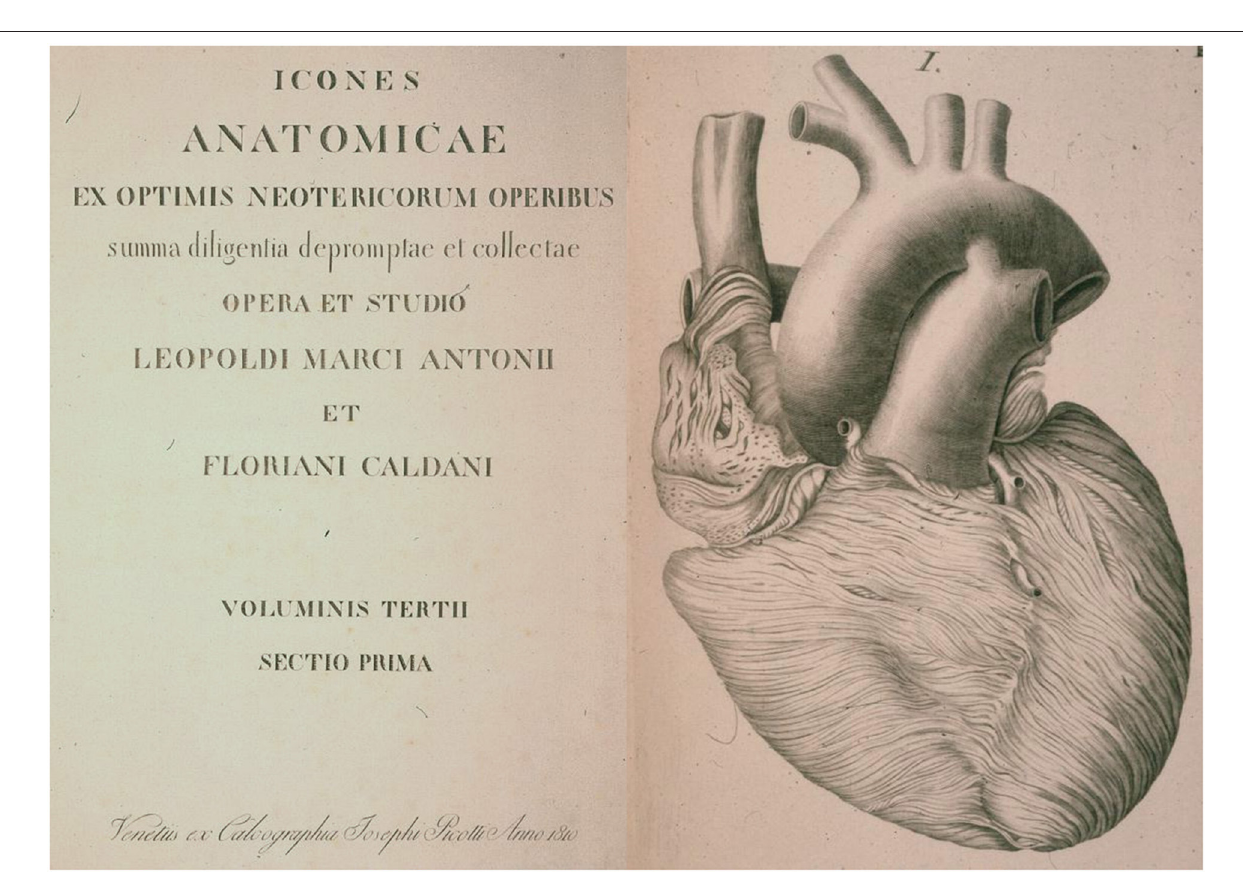
spaces lined by the endocardium ( Figure 12a ). This source of blood to the primitive spongy myocardium disappears with the myocardial compaction ( Figure 12b